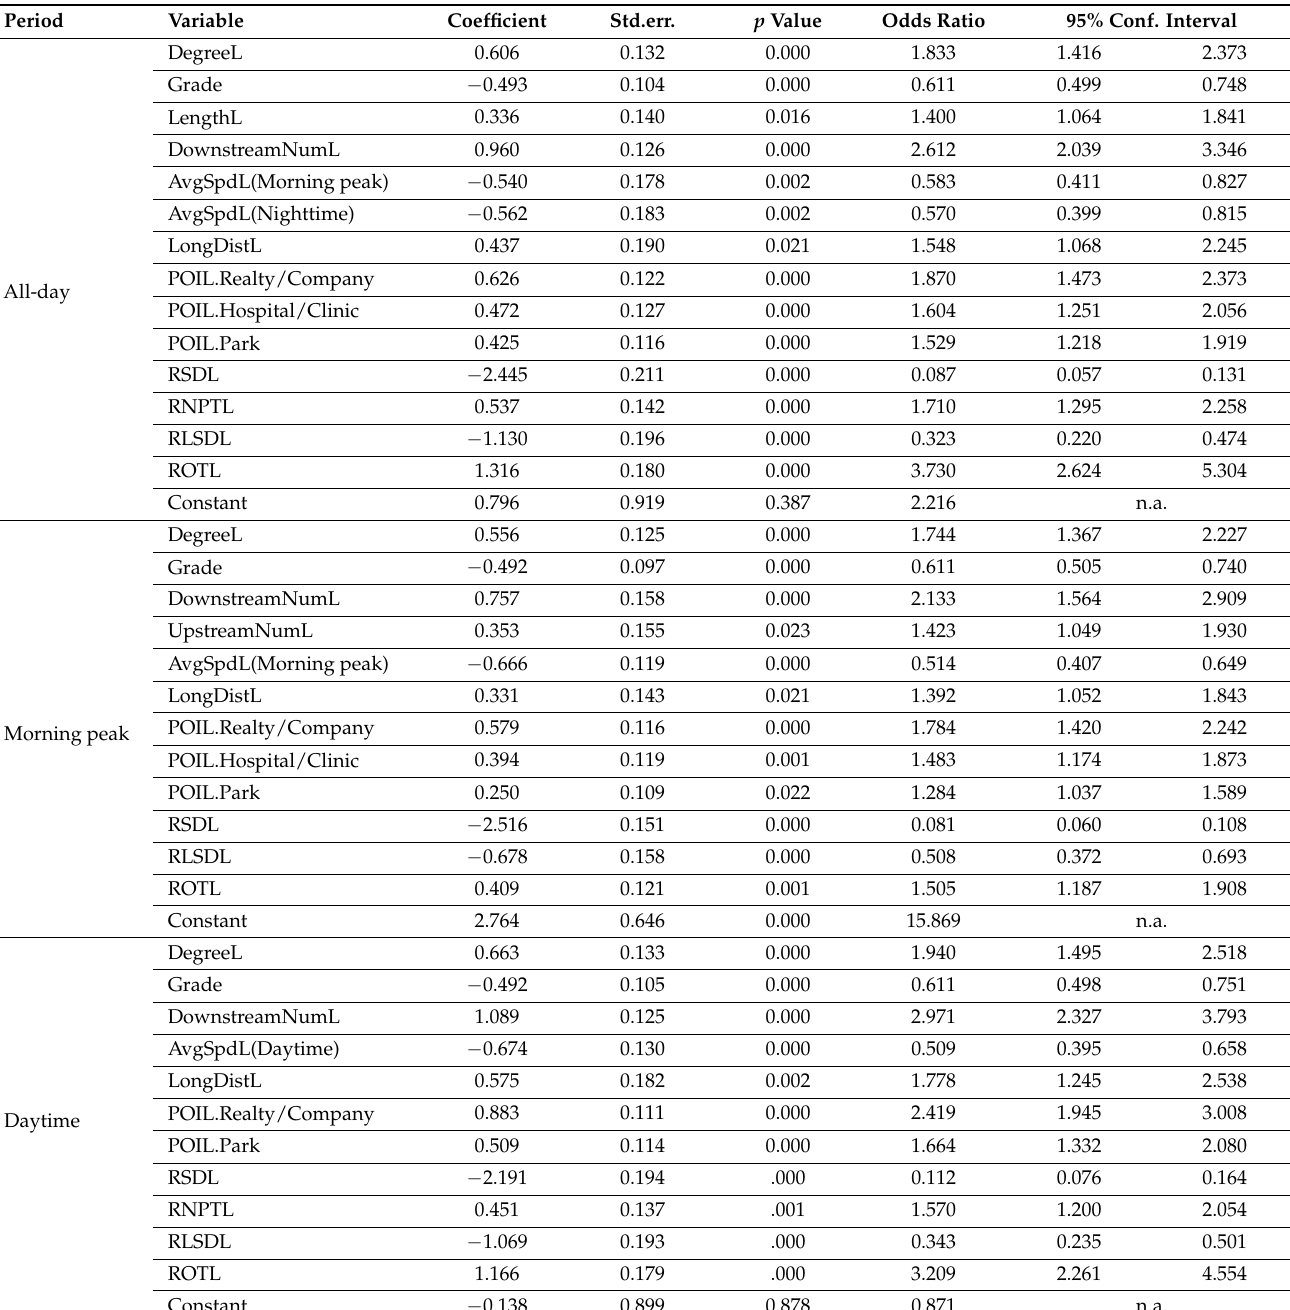
Table 5. Results of the SBL